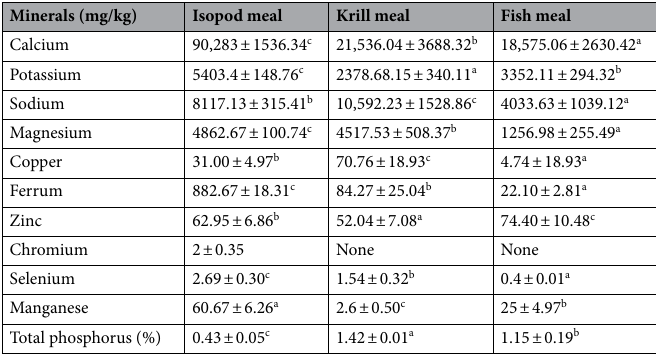
Table 6. Minerals composition of isopod meal, Antarctic krill meal and fishmeal. Numerical values marked with the same letter a,b or c are not statistically significant different at the p < 0.05 level.